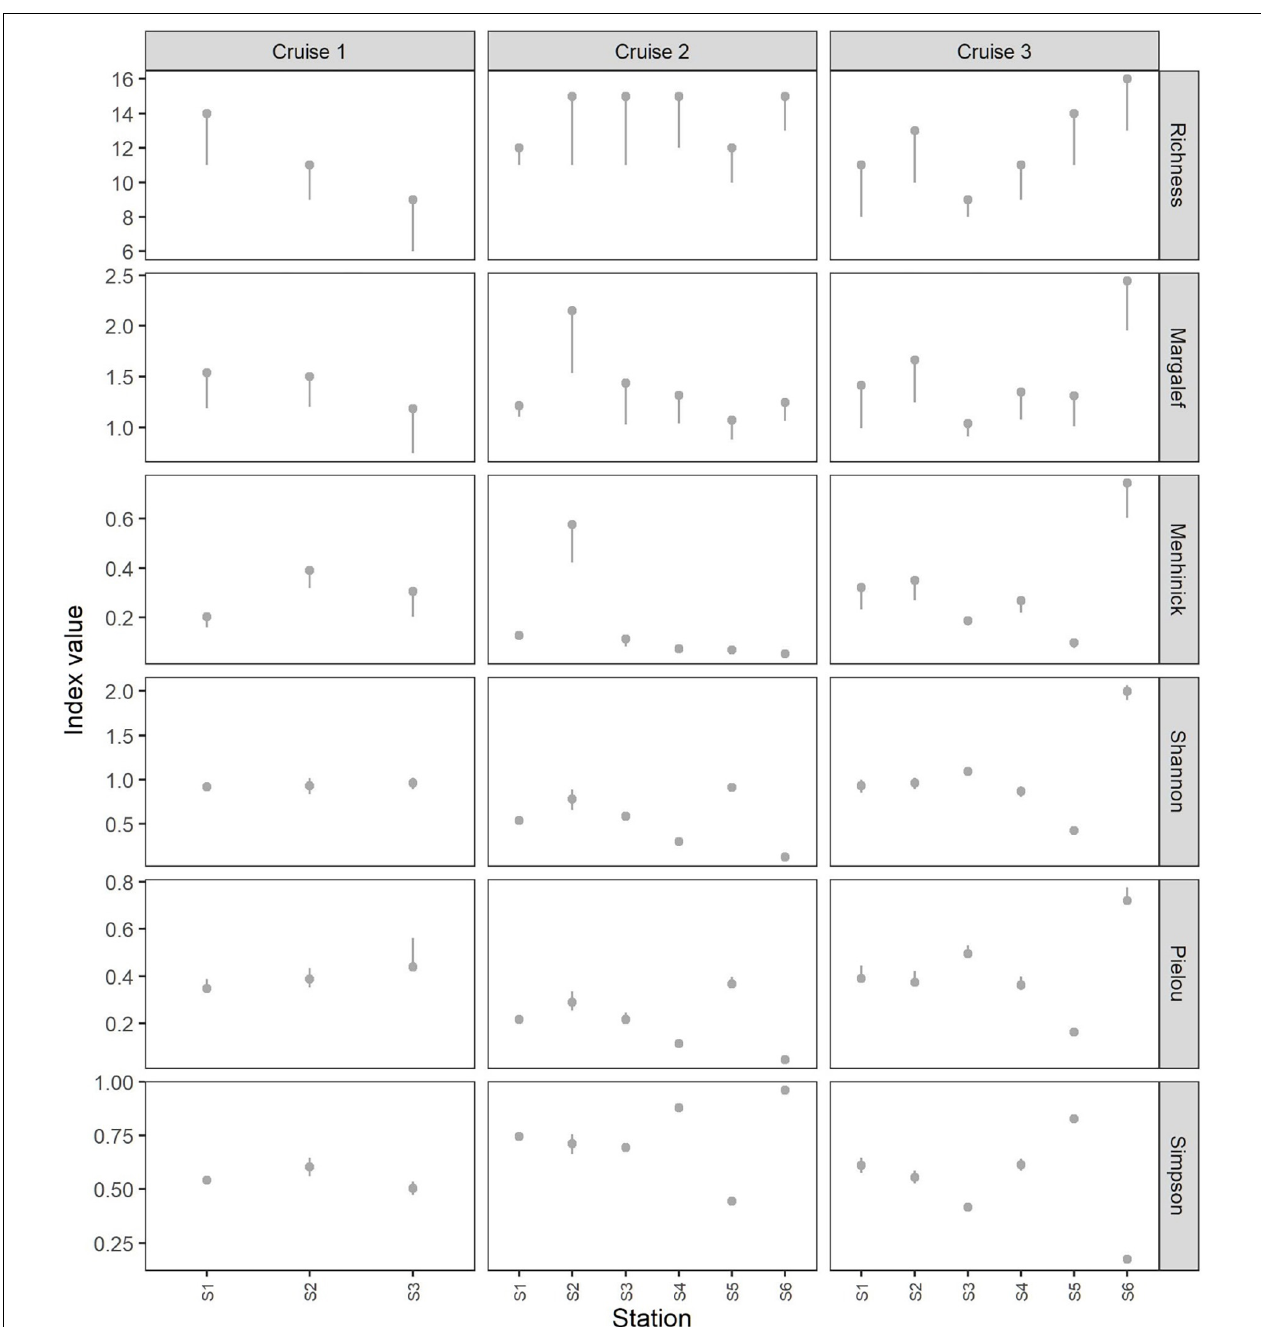
FIGURE 2 | Values of different biodiversity indices estimated for each station and each cruise. Error bars represent 95% confidence